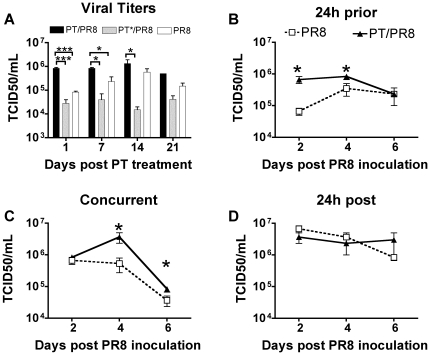
Effect of prior, concurrent and delayed PT treatment on influenza.(A) C57BL/6 mice were intranasally treated with 100 ng of PT, PT* or with PBS and infected with influenza PR8 (600 PFU) at the indicated times post PT treatment. Mean pulmonary viral titers were determined 2 days post-virus inoculation. (B–D) Mean pulmonary viral titers of mice treated with 100 ng of PT or PBS (control) 24 h prior (B), concurrently with (C), or 24 h post (D) infection with influenza PR8. Titers were determined 2, 4 and 6 days post virus inoculation. n = 3 mice/treatment group. *Significantly different from control (P<0.05).